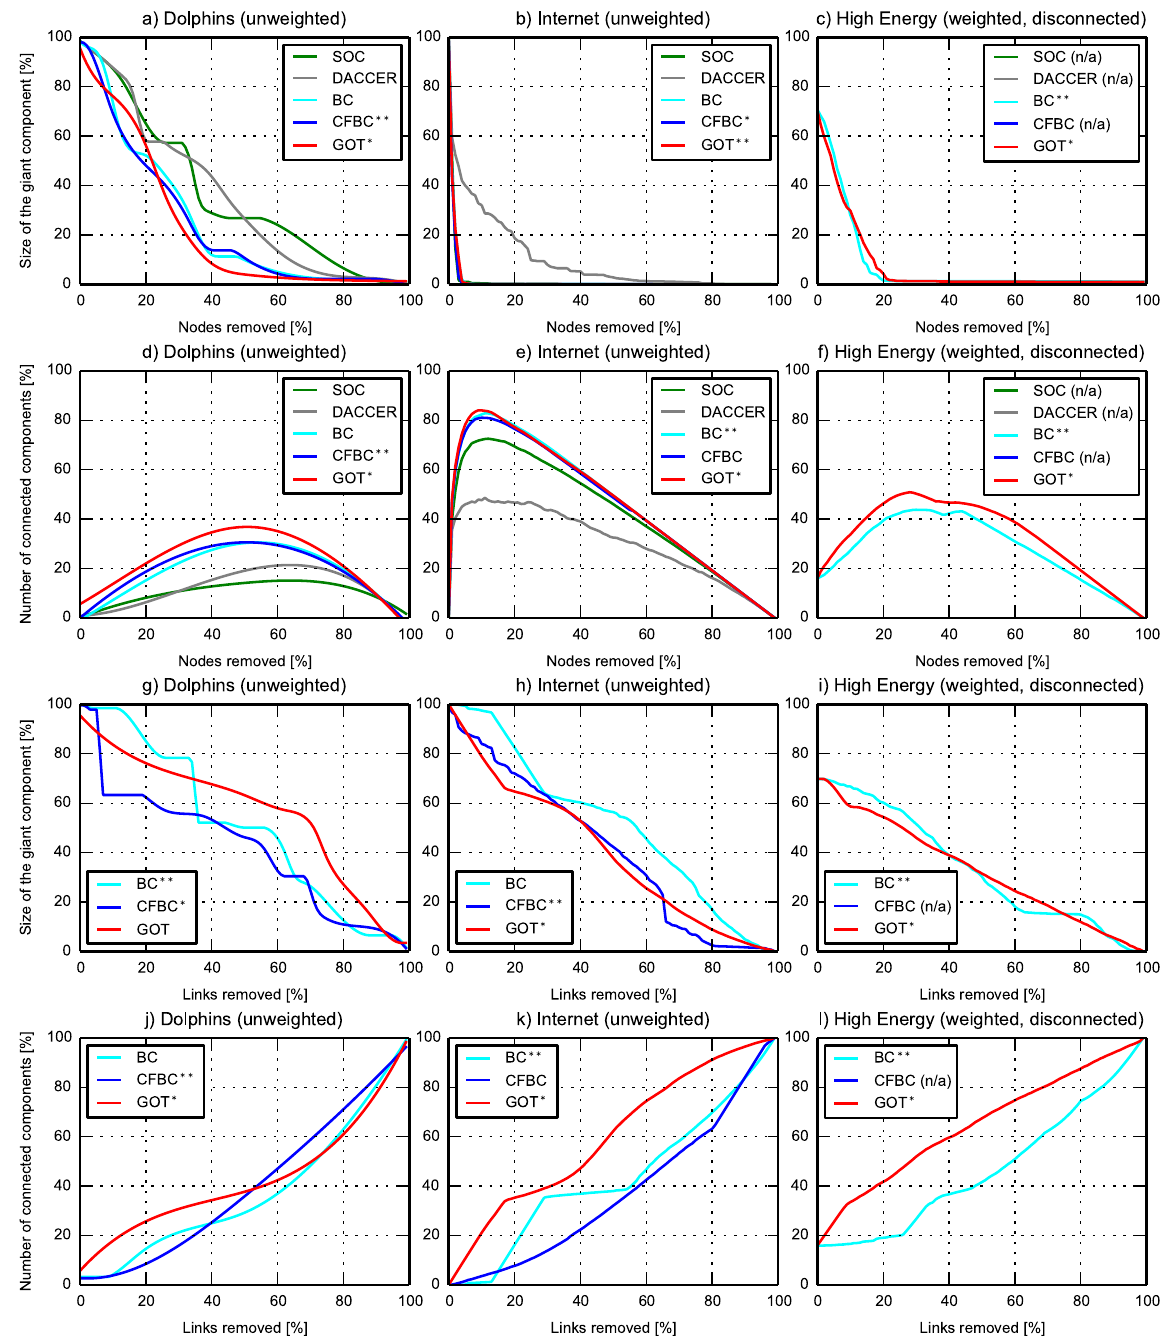
Figure 6. GOT accuracy - real-world networks. The evolution of the size of the giant component and of the number of connected components during the NRP procedure in three real-world networks: Dolphins (62 nodes, 159 links, unweighted), Internet (22963 nodes, 48436 links, unweighted), and High Energy (8361 nodes, 15751 links, weighted, disconnected). The y-axes give figure of merit, while the x-axes represent percentage of node and links removals, respectively. The top subplots depict the performance of nodes centrality metrics. The bottom subplots show the links centrality